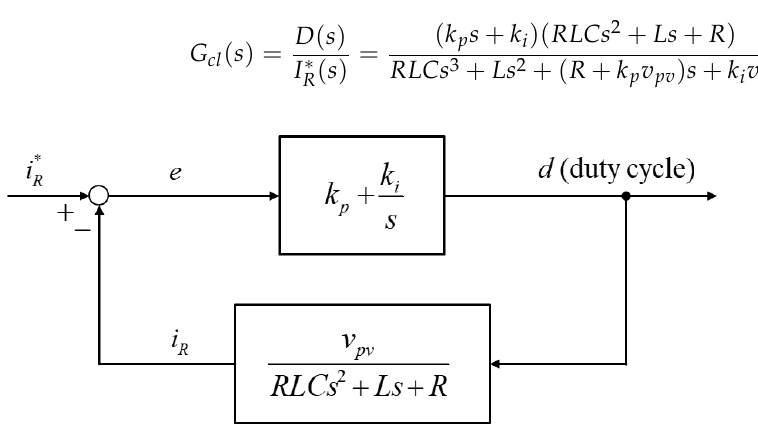
Figure 6. The transfer function block diagram of the PV current control system.